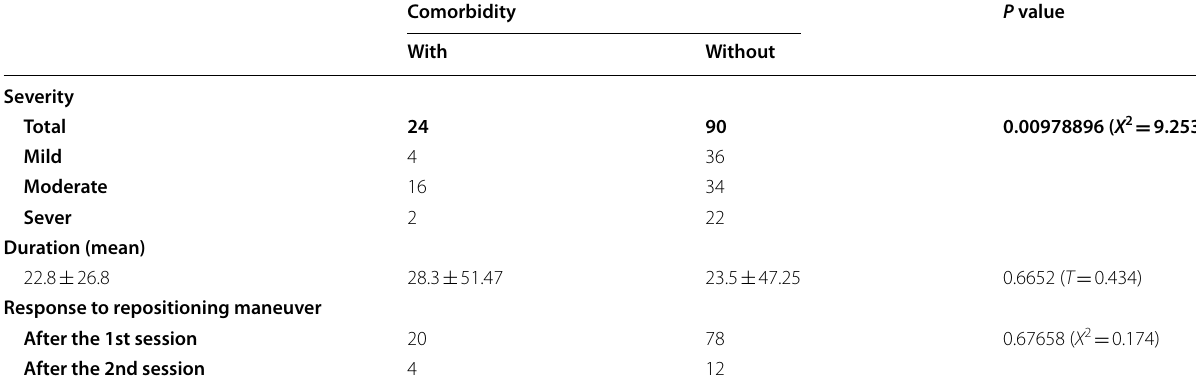
Table 4 The comorbidity in relation to severity of symptoms, duration, and response to management Comorbidity P value With